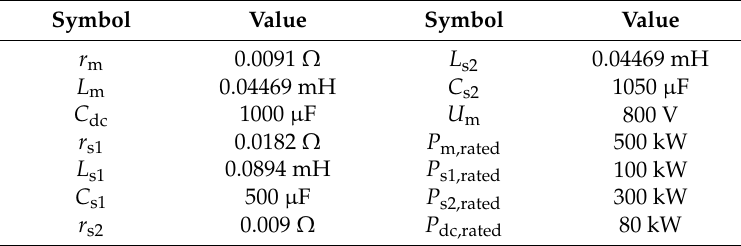
Table 1. Parameters of equivalent structure of LV multi-terminal AC/DC hybrid system.